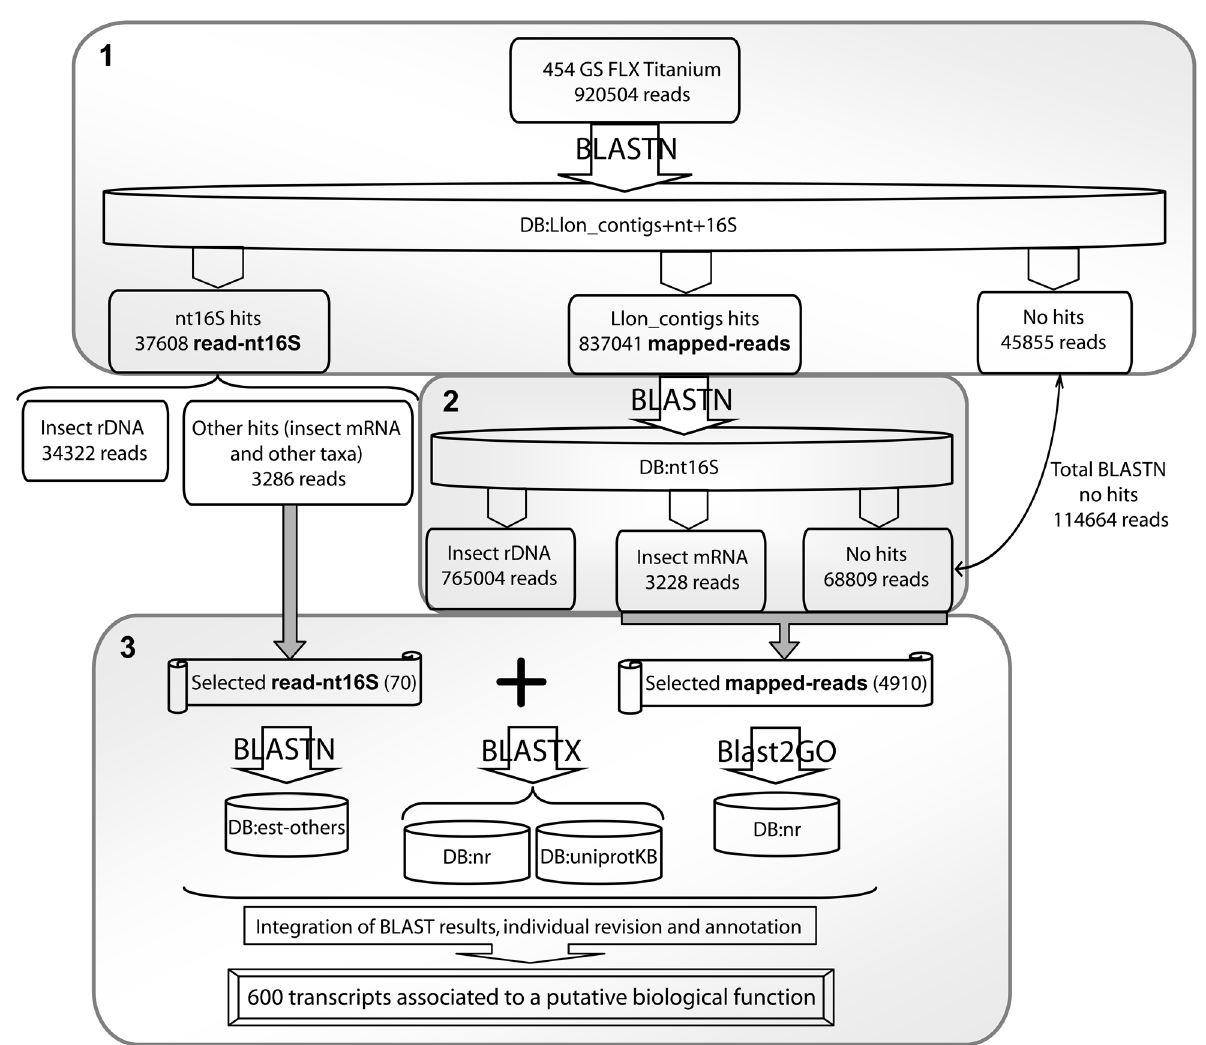
Figure 1. Sequence analysis workflow. This figure shows an overview of the rationale supporting the analysis of the reads (transcripts) obtained in this study and summarises the different steps that were followed. 1) Indicates the first stage of analysis, in which all the reads were blasted against DB:Llon_contigs + nt + 16S. Results were classified in three datasets: reads that mapped to Llon_contigs by sequence homology (mapped-reads); reads that showed homology to nt16S (read-nt16S); and reads that returned no significant hits (no hits) (see text for details). 2) Indicates the second stage of analysis, in which the mapped-reads dataset was blasted against DB:nt16S (see text for details). 3) Indicates the third stage of analysis, in which selected reads (mapped-reads and read-nt16S) were separately blasted against three databases (est-others, nr and uniprotKB) and annotated using Blast2GO (see text for details). The ‘selected mapped-reads (4910)’ excluded mapped-reads 15379, 23694, 25834, 27903, 27904 and 9281, which showed homology to insect rDNA after BLASTN against DB:nt16S, and contig 31202, with unknown function after BLASTN against DB:nt16S (see text for details). The ‘selected read-nt16S (70)’ included read-nt16S that did not show homology to either insect rDNA or taxa other than insects (see text for